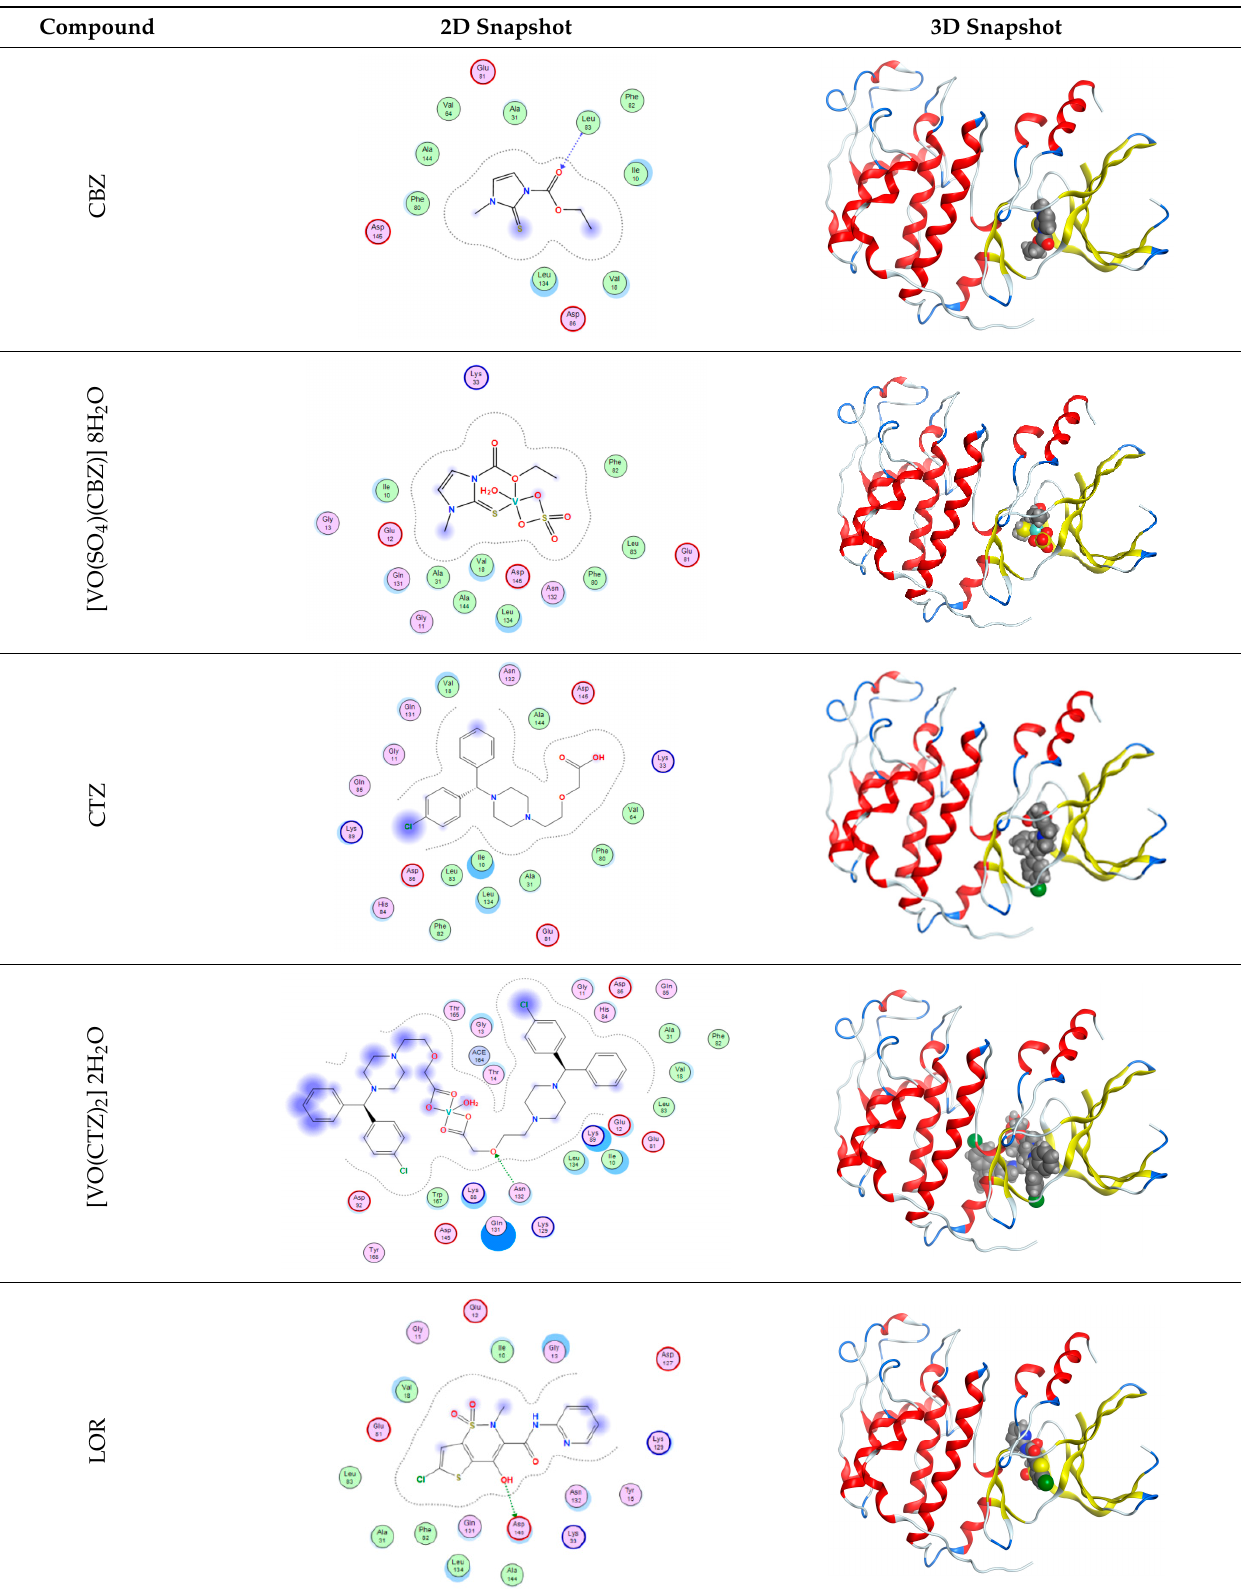
Table 10. 2D and 3D Docking interaction of the oxidovanadium(IV) complexes with colon cancer protein (PDB code = 3IG7).